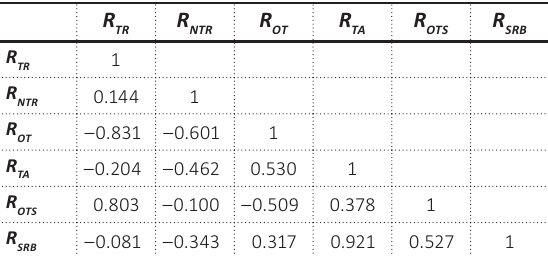
Table 6. Correlation matrix of fiscal policy decentralization indicators by local budget